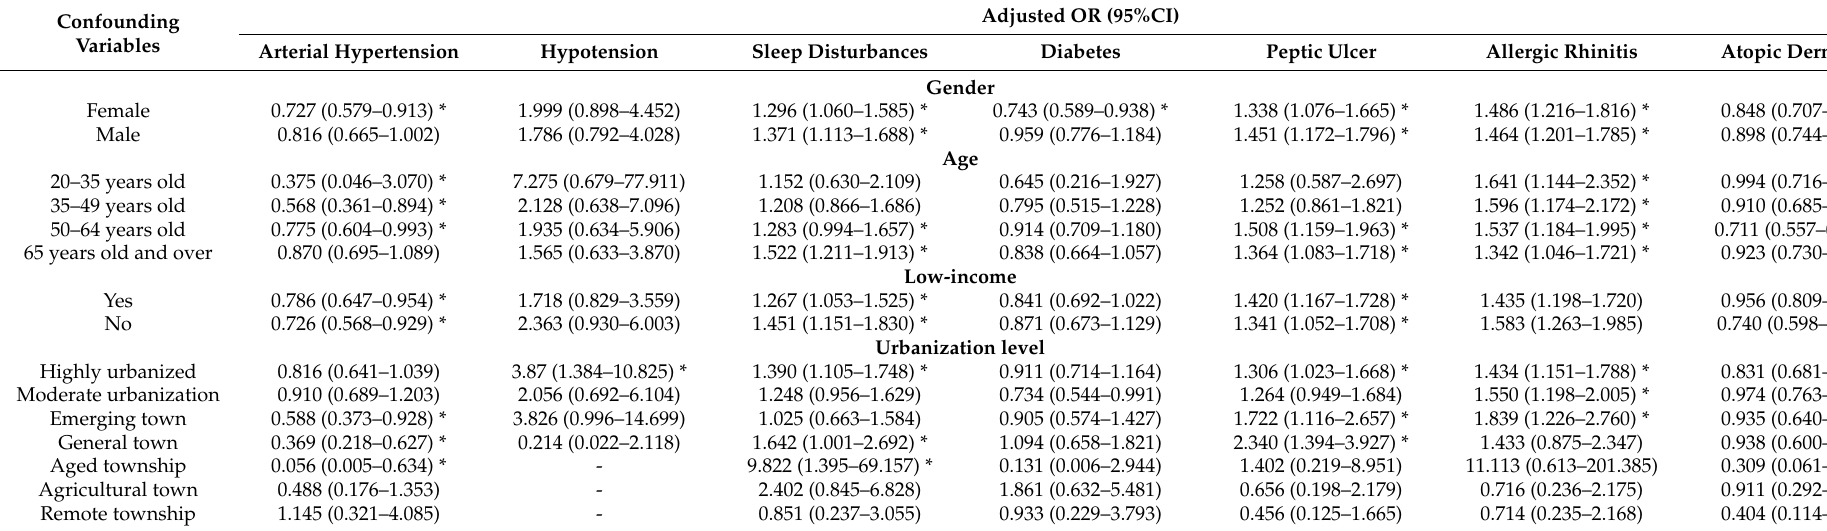
Table 3. Logic regression analysis of NTG and POAG in